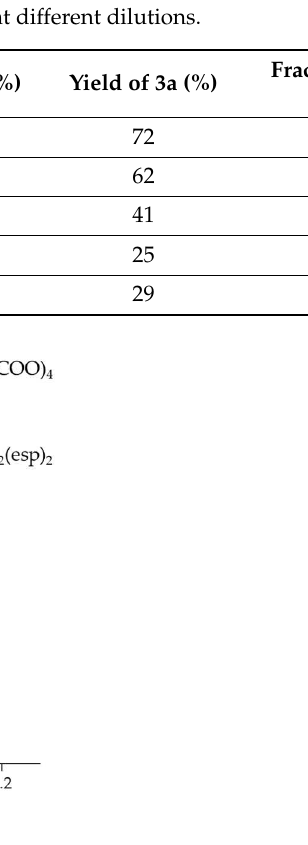
Figure 5. Linear relationship between parameters k and b for catalysts investigated herein.